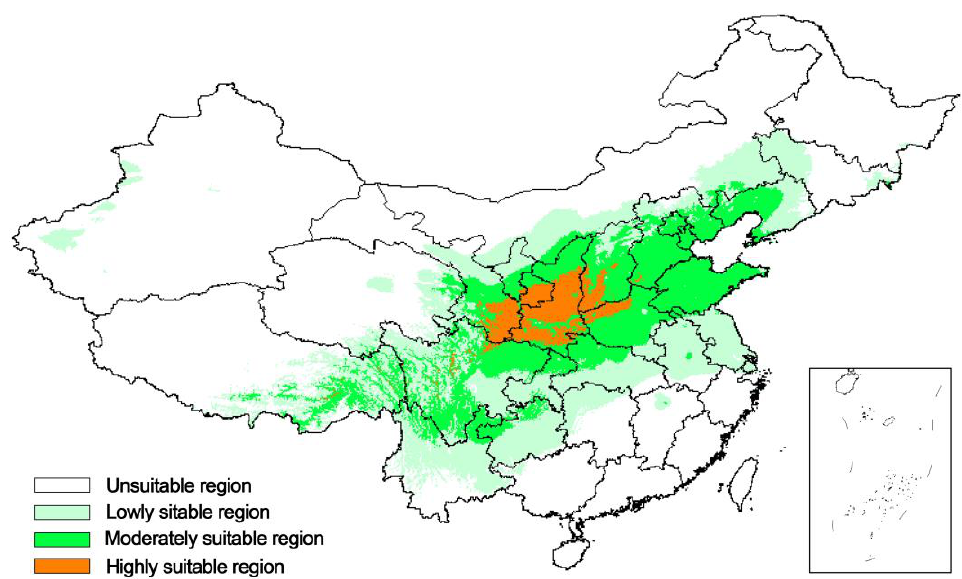
Figure 5. Potential geographical distribution of P. tomentosa under contemporary climate conditions.